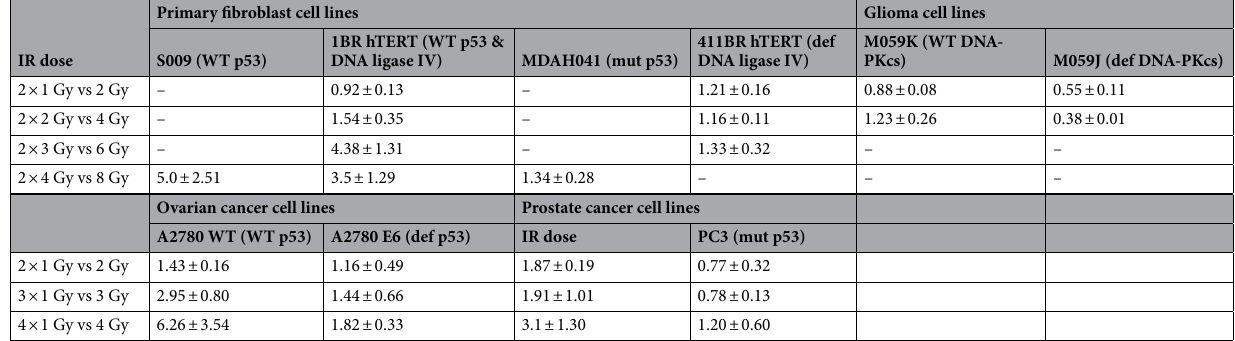
Table 1. Summary of recovery factors (RF: ratio of split-dose to single dose survival) observed in selected primary and malignant cell lines (a) fibroblast and glioma cell lines, (b) ovarian and prostate cancer cell lines. All values are shown as mean ± standard deviation (n =